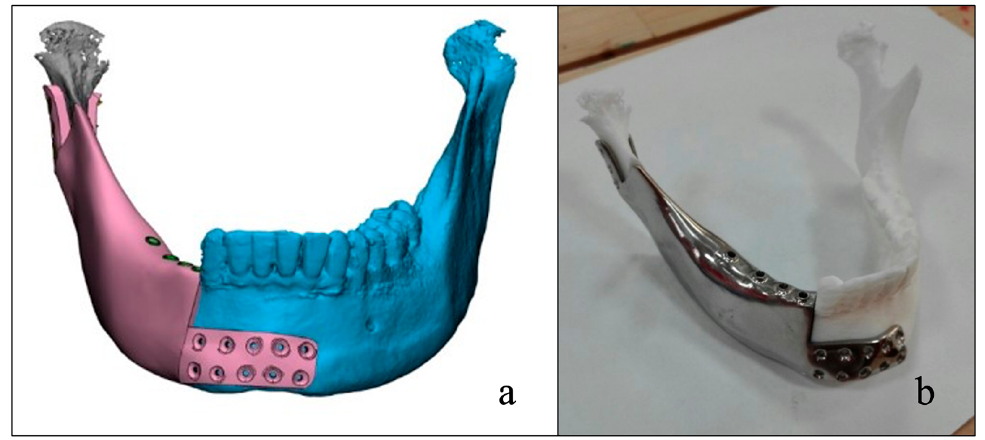
Figure 11. ( a ) Simulation of the general shape of the mandibular prosthesis delineated from the mirrored image of the unaffected side on 3D models in frontal view; ( b ) CAD-CAM custom-made mandibular prosthesis.